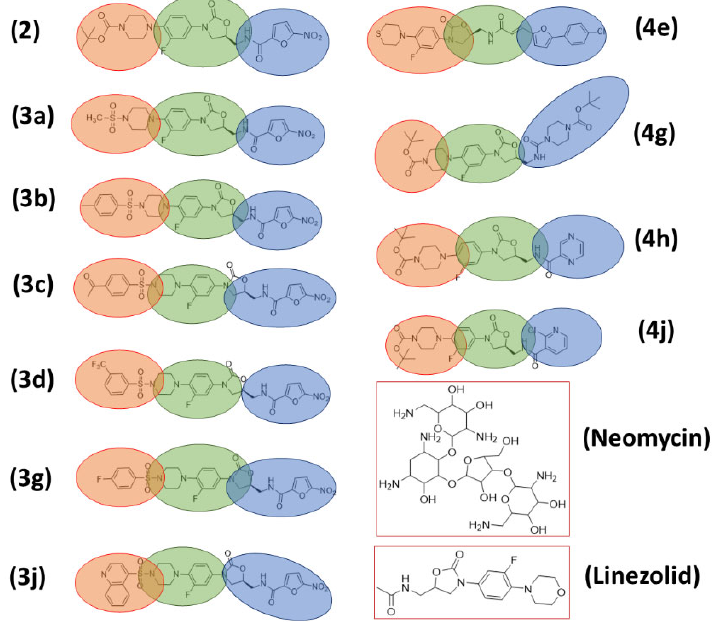
Pharmaceuticals 2023 , 16 , x FOR PEER REVIEW Figure 6. Functional group-based decomposition of oxazolidinone. Figure 6. Functional group-based decomposition of oxazolidinone.